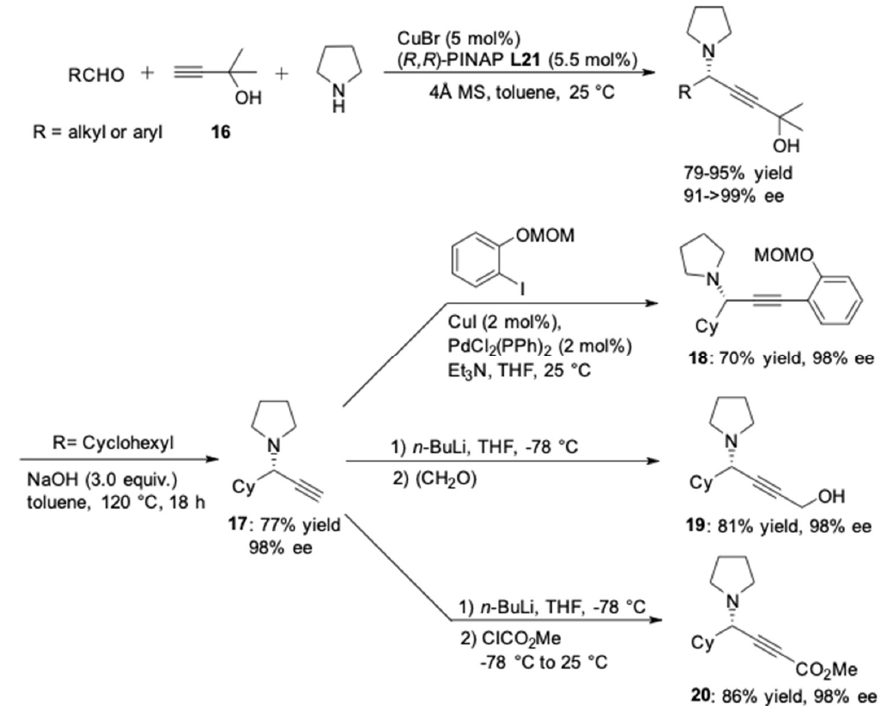
Figure 20 . AA 3 -couplings utilizing pyrrolidine as the secondary amine. Figure 20. AA 3 -couplings utilizing pyrrolidine as the secondary